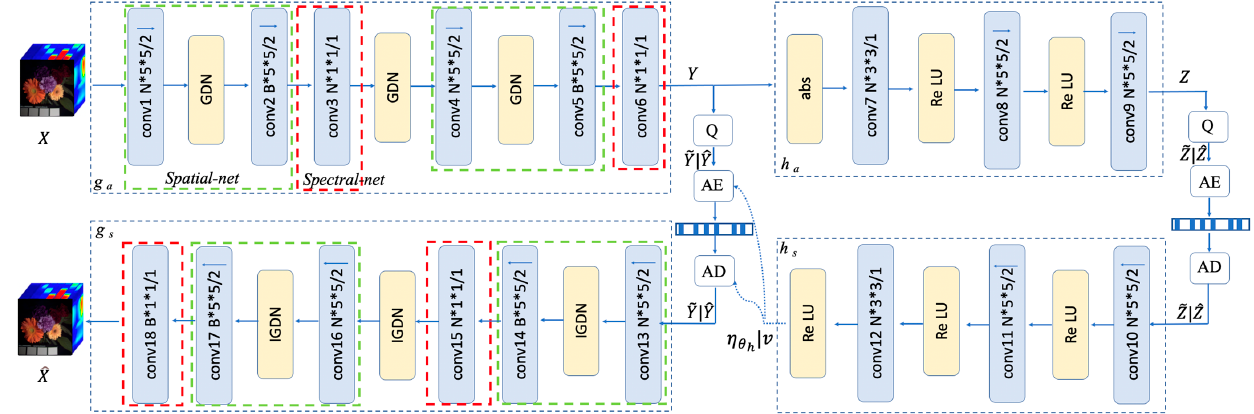
Figure 5. The HSI compression architecture. The green and red boxes, on the left side, represent spatial and spectral networks, respectively. Q indicates quantization, and AE and AD correspond to the arithmetic encoder-decoder pair. For the convolution operation, parameters are described as the number of filters × kernel size (height × width)/down-sampling/up-sampling stride (the factor is 2), where <- denotes up-sampling and -> down-sampling. B is the band number of HSIs (in this paper, B = 31 for CAVE and KAIST datasets and B = 102 for ROSIS-Pavia data). N is the number of filters; we find performance gains will stagnate when the number of filters is increased to a certain level, and N = 192 yields a good performance in our